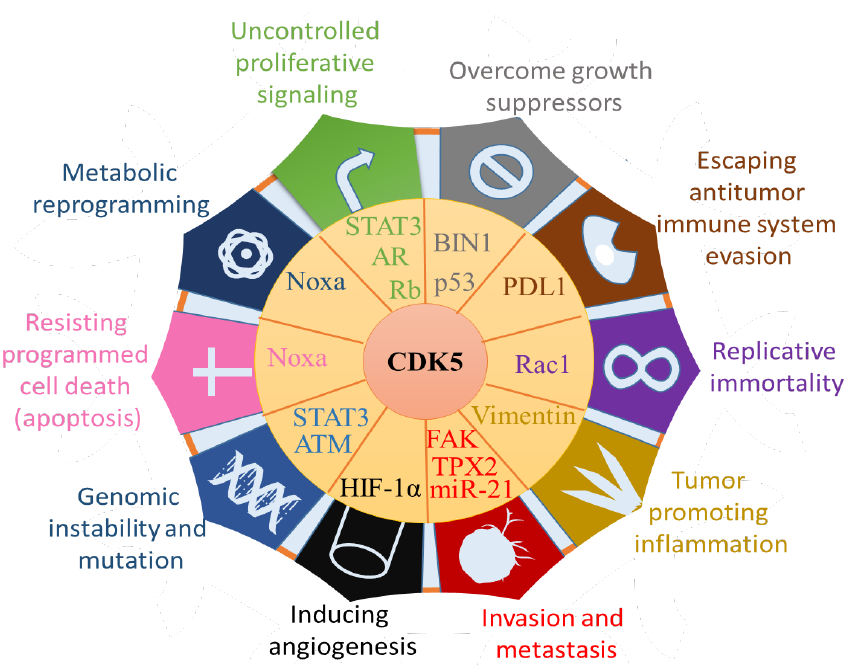
Figure 4. Impacts of CDK5 on the hallmarks of cancer: Uncontrolled proliferative signalling, Over- come growth suppressors, escaping antitumor immune system evasion, replicative immortality, tumour promoting inflammation, invasion and metastasis, inducing angiogenesis, genomic instabil- ity and mutation, resisting programmed cell death, metabolic reprogramming. Through the effect on the target protein, CDK5 is conducive to tumour development and metastasis. Abbreviations: phorbol-12-myristate-13-acetate-induced protein 1 (Noxa), Signal transducer and activator of tran- scription 3 (STAT3), androgen receptor (AR), retinoblastoma (Rb), bridging integrator 1 (BIN1), programmed cell death ligand 1 (PD-L1), focal adhesion kinase (FAK), targeting protein for Xklp2 (TPX2), hypoxia-inducible factor-1 α (HIF-1 α ), ataxia-telangiectasia mutated (ATM). (Line